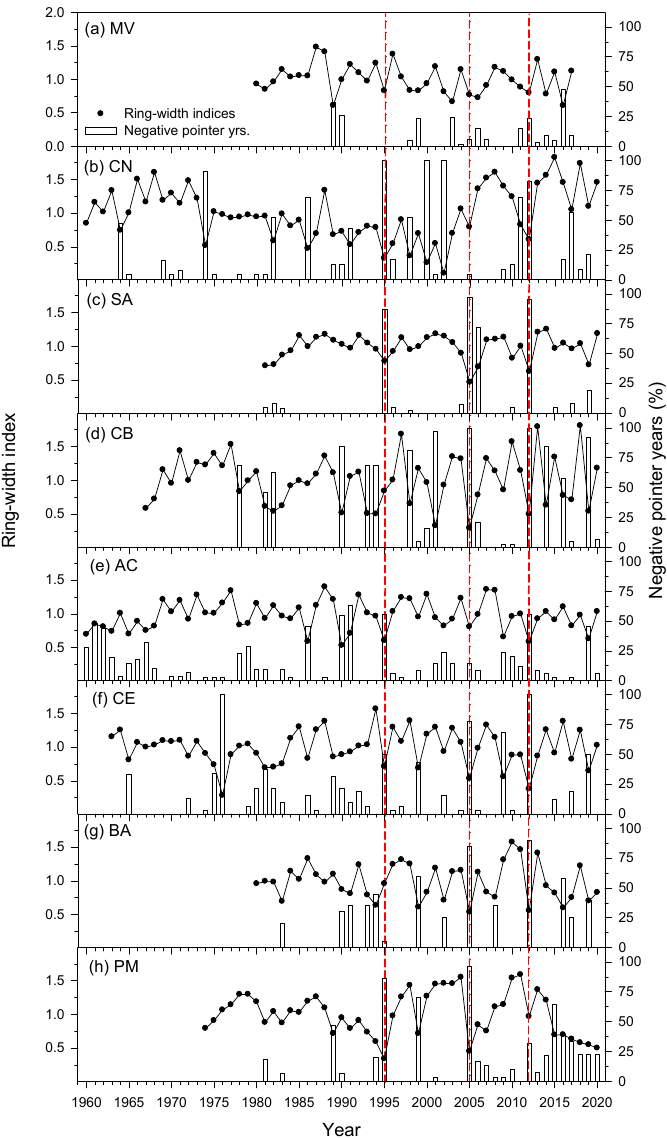
Figure 1. Site chronologies (mean series of ring-width indices) and percentage of negative pointer years (right y-axes) obtained for the studied Atlas cedar plantations: ( a ), MV, Valliguières; ( b ), CN, Berriozar; ( c ), SA, Sariñena; ( d ) CB, Bañón; ( e ) AC, Monte Abantos; ( f ) CE, Monte Mario-Béjar; ( g ) BA, Baza; and ( h ) PM, Puerto de la Mora. The dashed vertical lines indicate the 1995, 2005 and 2012 droughts.